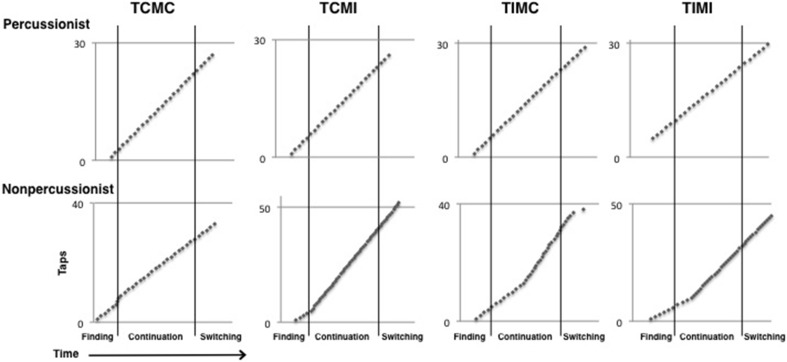
Beat tapping profiles for each of the four conditions in the beat tapping task from one percussionist and one nonpercussionist participant. The nonpercussionist's tapping rate fluctuates more than the percussionist's rate in each of the 4 conditions.